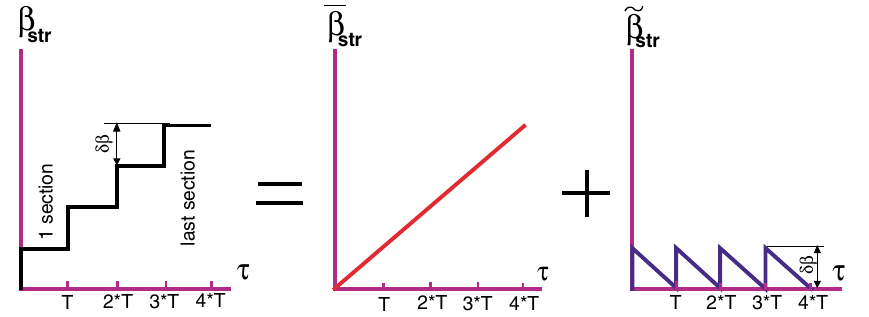
FIG. 2. (Color) Representation of velocity function in the stepped phase velocity structure.